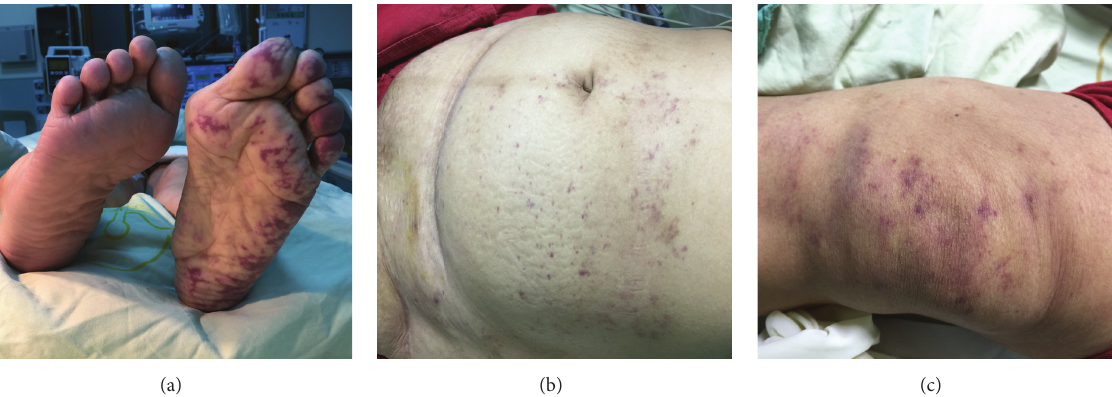
Figure 1: (a) A tattoo-like purpuric rash over the left plantar region was observed. (b) Petechiae on the lower abdomen region. (c) Petechiae on the left knee region with no obvious pitting edema on the left lower limb or knee joint were